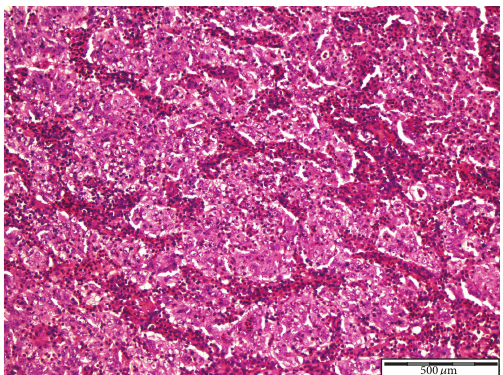
Figure 2: Lymphoepithelioma-like carcinoma of the urinary blad- der showing neoplastic cells with syncytial growth pattern, sur- rounded by inflammatory cells Haematoxylin and Eosin staining × 10 magnification reproduced from [3] (http://dx.doi.org/10.7707/ hmj.v6i3.245) with permission from Hamdan Medical